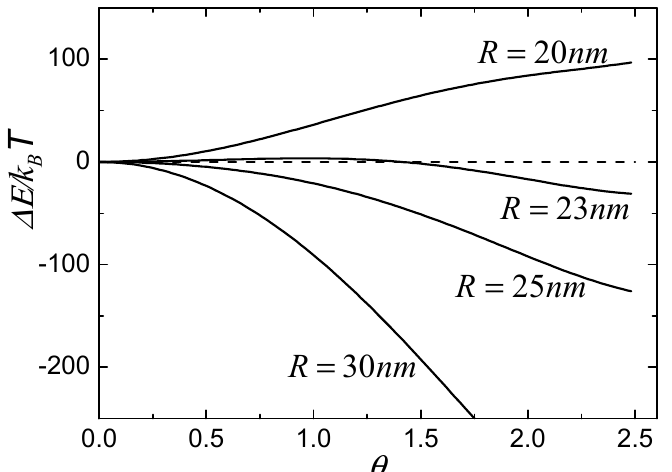
Δ Figure 3. Free energy change, ∆ E , as a membrane wraps around a spherical particle with wrapping Figure 3. Free energy change, E , as a membrane wraps around a spherical particle with wrapping θ degree θ for different radii of degree for different radii of NPs.